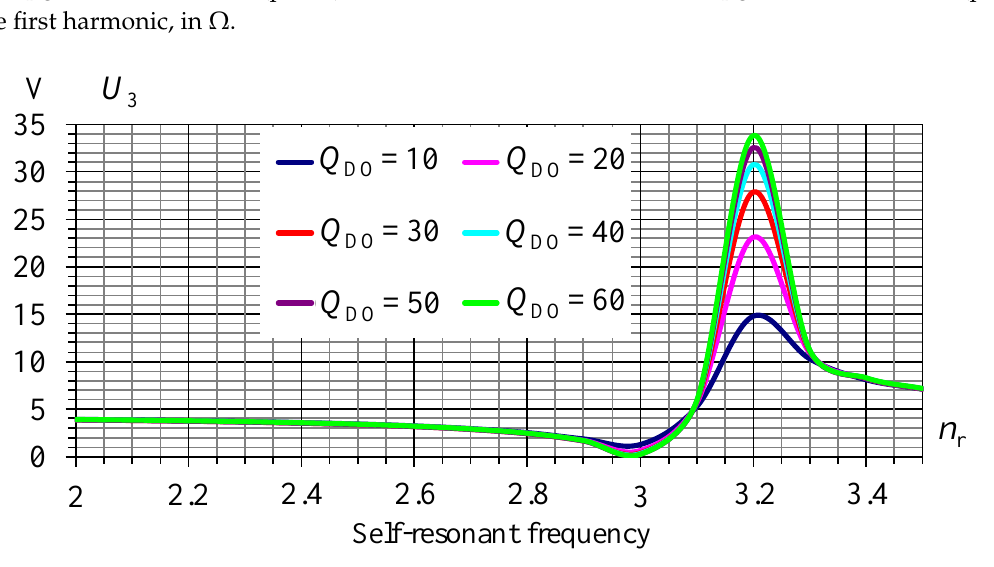
Figure 4. RMS value of third harmonic voltage in the transmission system as a function of the self-resonant frequency at different values of the choke Q DO -factor.